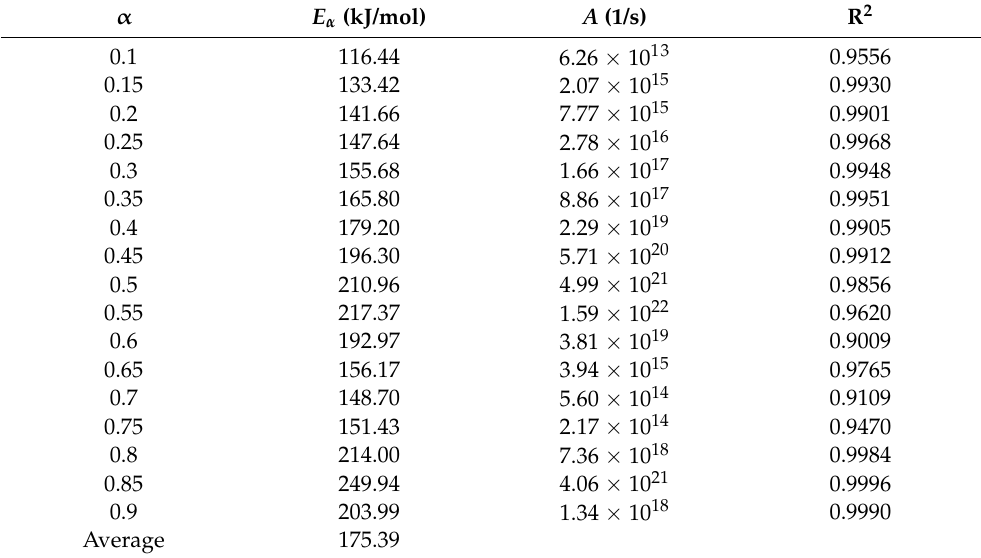
Table 2. Kinetic parameters of sunflower husk pellets obtained by OFW